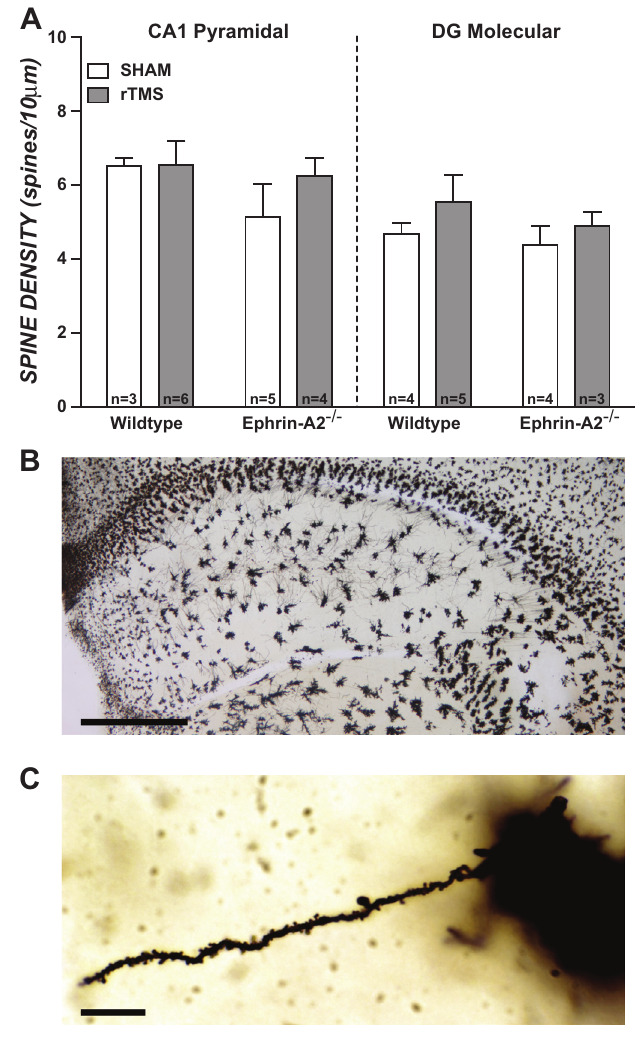
Figure 2. Assessment of rTMS effects on dendritic spine density in wildtype and ephrin-A2 -/- knockout mice. ( A ) Mean dendritic spine density (number of spines per 10 μm) for hippocampal regions: CA1 pyramidal layer and dentate gyrus molecular layer (DG Molecular). There were no significant effects of rTMS nor genotype on spine densities in either region ( p values >0.05; ANOVA). Error bars = SEM. ( B ) Right hemisphere Golgi stained section of dorsal hippocampus representative of those used in analyses. Scale bar represents 500 μm. ( C ) Dendrite representative of those selected for analysis, with spines visible. Scale bar represents 10